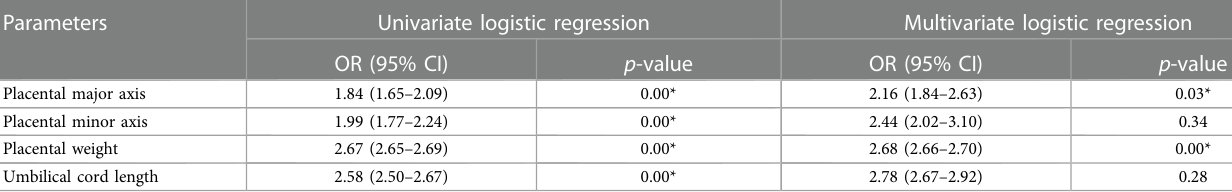
TABLE 4 Placental and umbilical cord risk factors for small for gestational age in preterm neonates of PIH